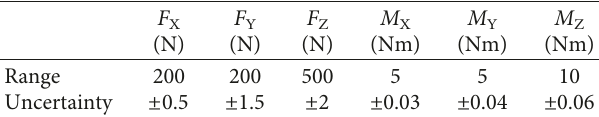
Table 2: Main parameters of the 6-dimension force/torque